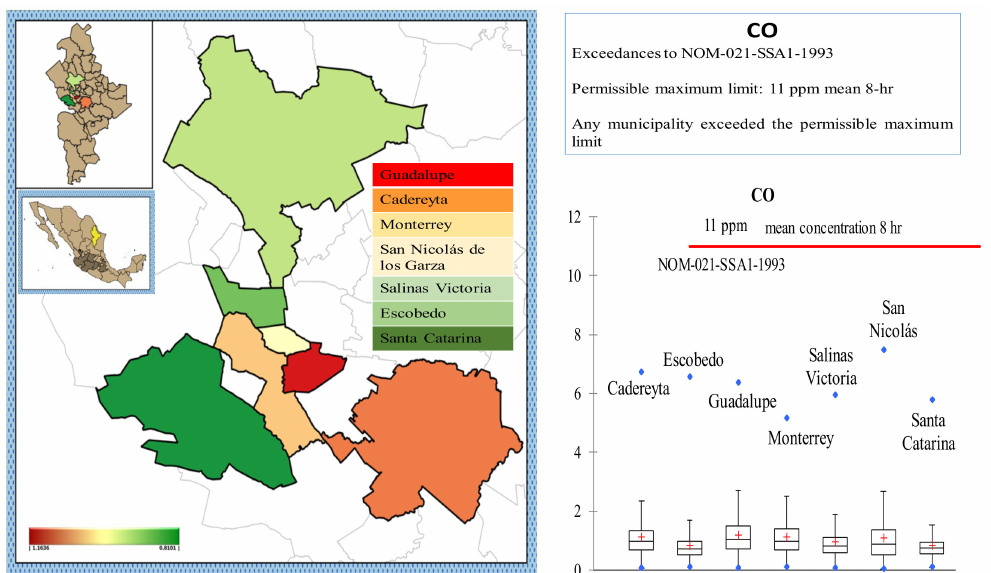
Figure 3. Mean concentrations of CO in MAM during 2016–2019.